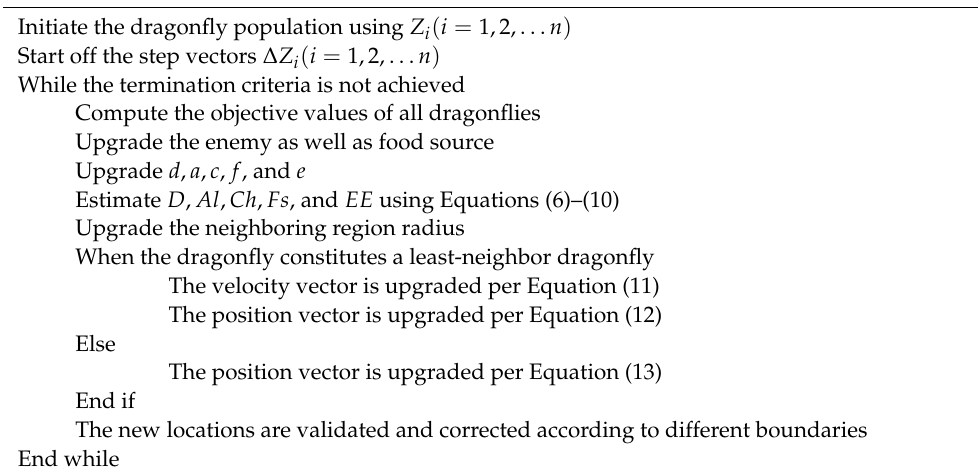
Algorithm 1: Pseudo code of conventional DA